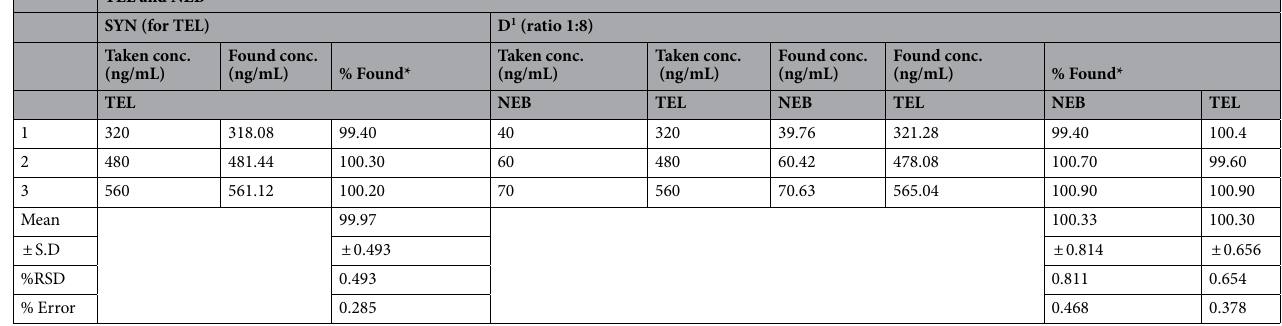
Table 4. Assay results for the concurrent assessment of TEL and NEB in synthetic mixtures using the studied synchronous and first derivative synchronous spectrofluorimetric techniques. *Mean of three determinations.